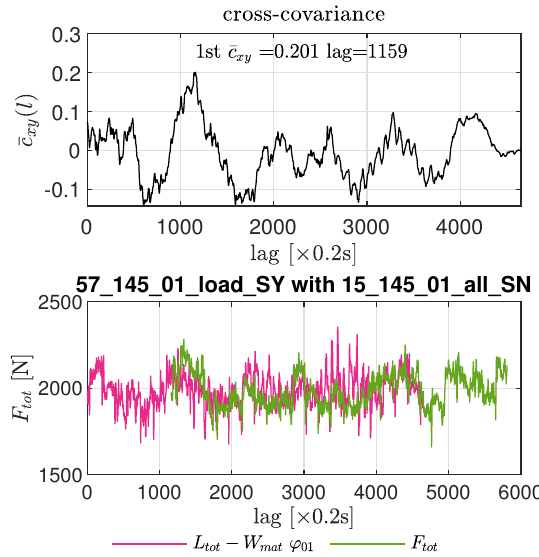
Figure 18: First example: Cross-correlation of measured force on roller with and without material being conveyed. In the bottom plot signal overlaid with shifted signal by 1st peak’s lag.